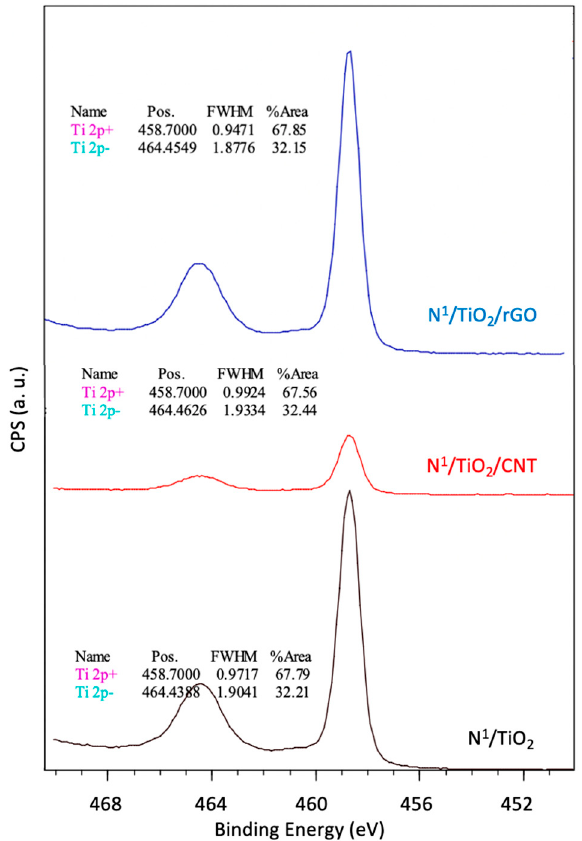
Figure 7. Narrow scan XPS spectra of Ti 2p of different synthesized N – doped TiO 2 – based